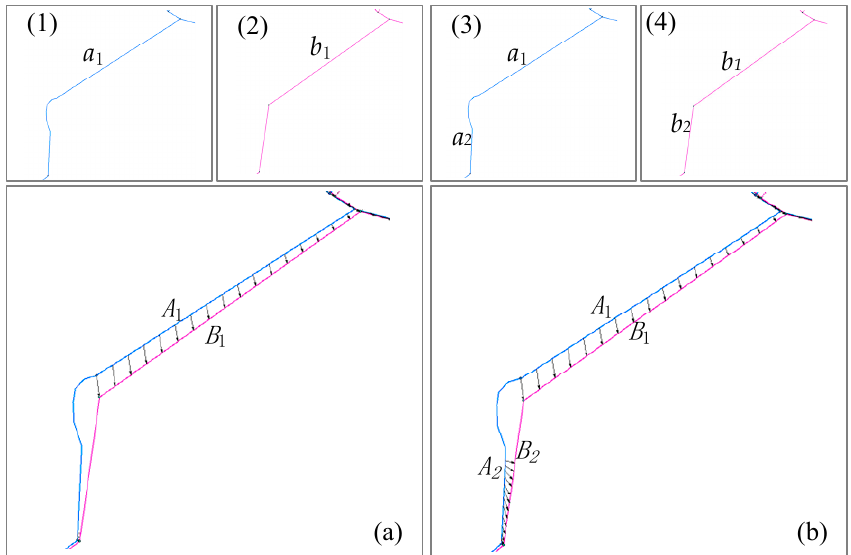
Figure 19. The node–segment algorithm missed a match, while the stroke algorithm results in some